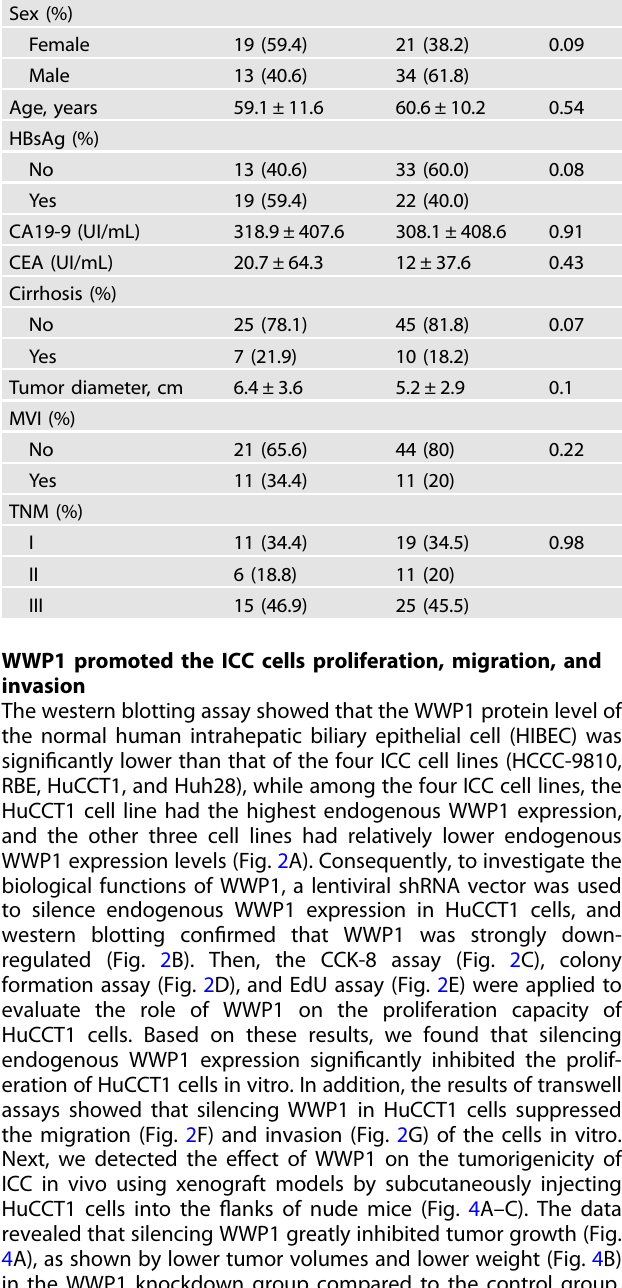
(Fig. 3C), and EdU assay (Fig. 3D), WWP1 overexpression promoted the proliferation of HCCC-9810 and RBE cells in vitro. In the